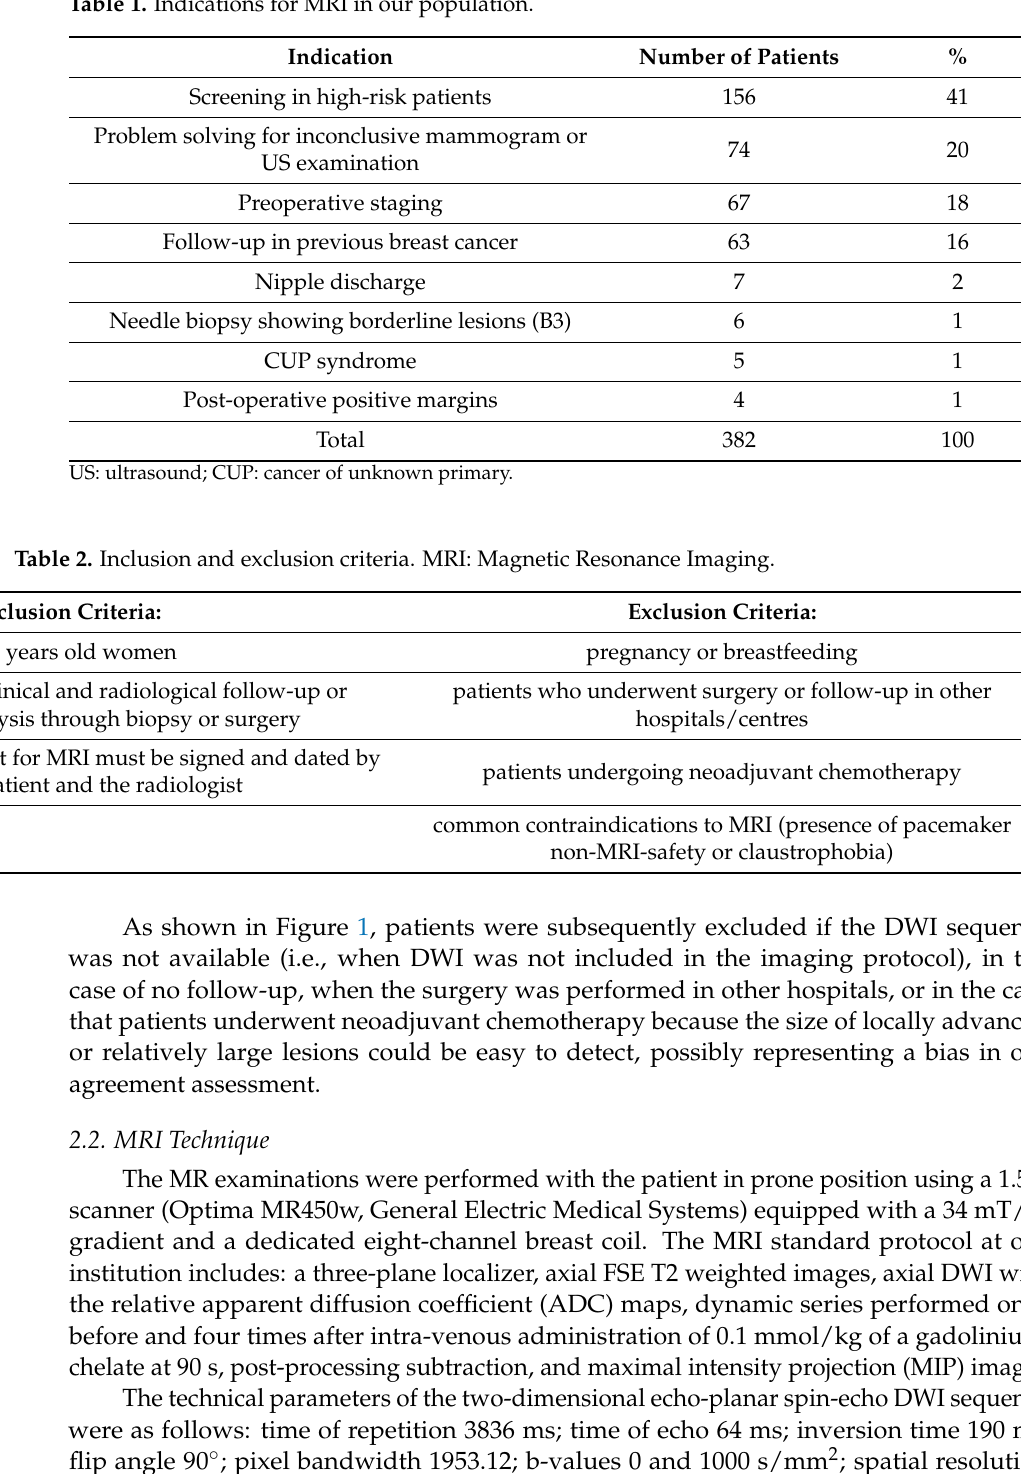
Table 1. Indications for MRI in our population.